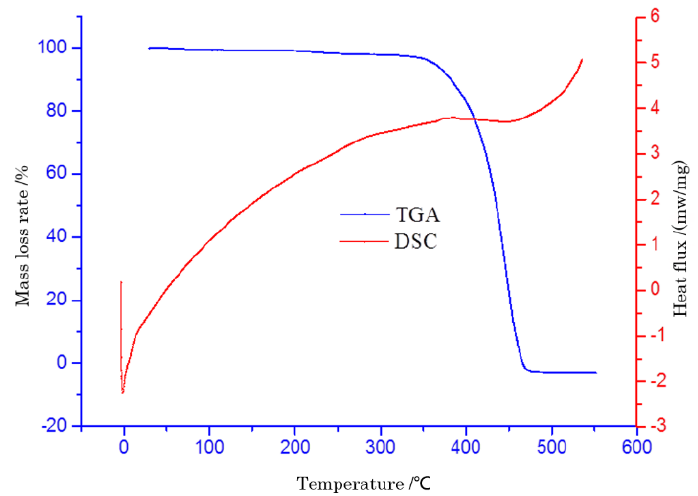
Figure 10. TG-DSC spectrum of PP-modified asphalt.